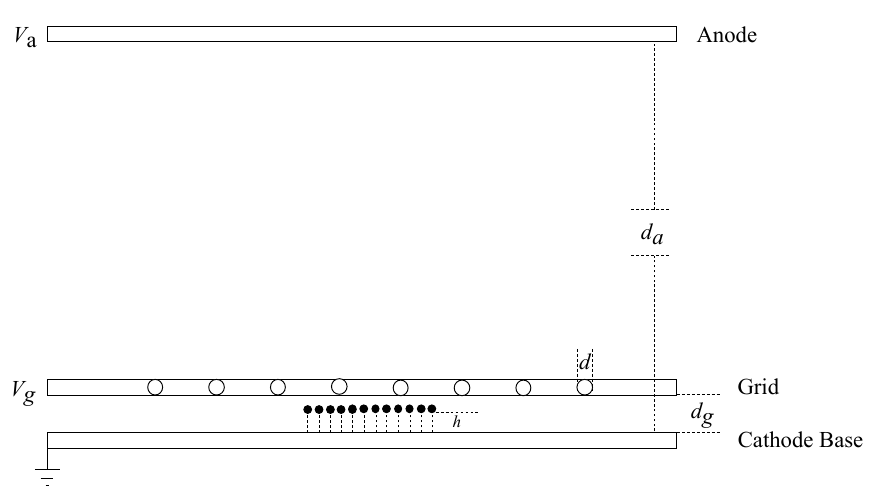
Figure 2. Simplified model of front-grid carbon nanotube